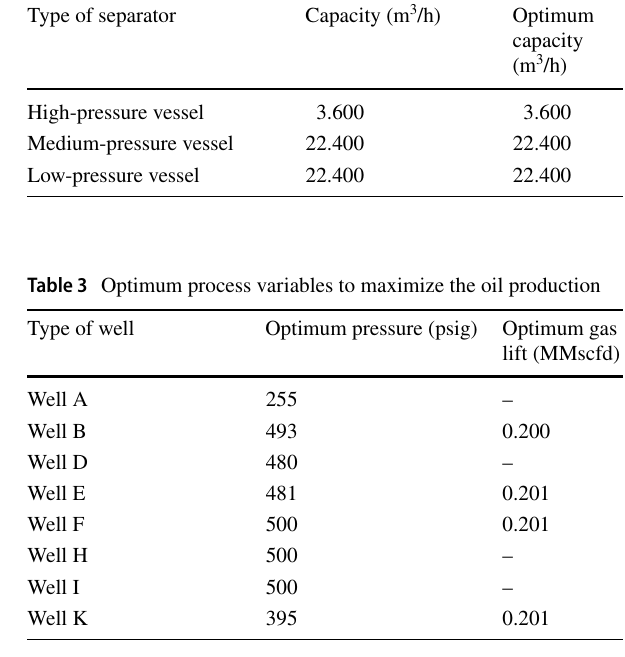
Table 2 Oil flowrate produced from each separation vessel